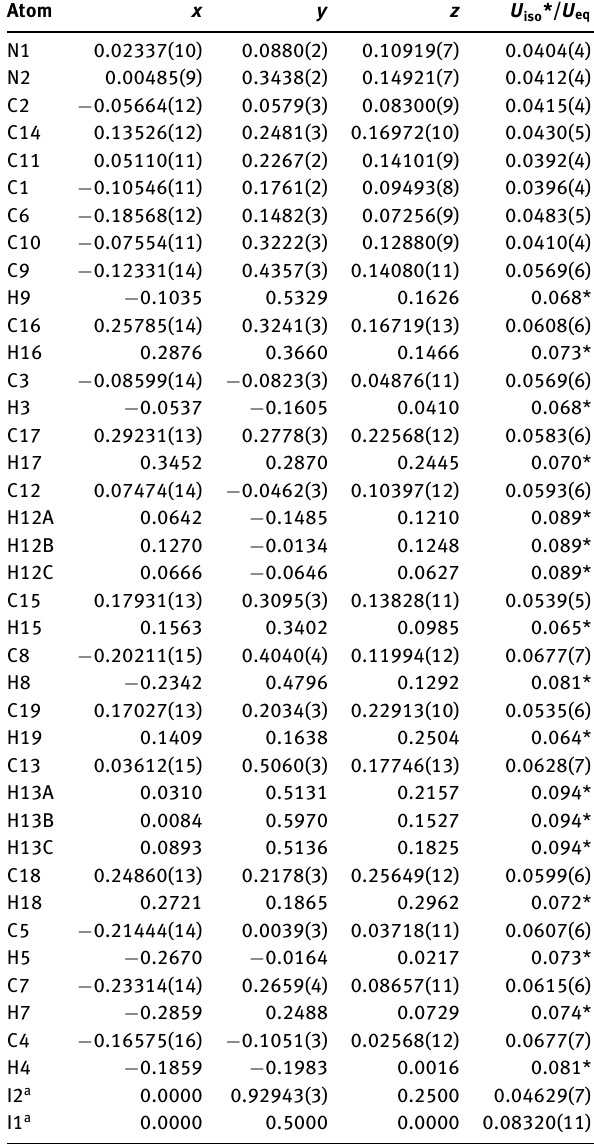
Table 2: Fractional atomic coordinates and isotropic or equivalent isotropic displacement parameters (Å 2